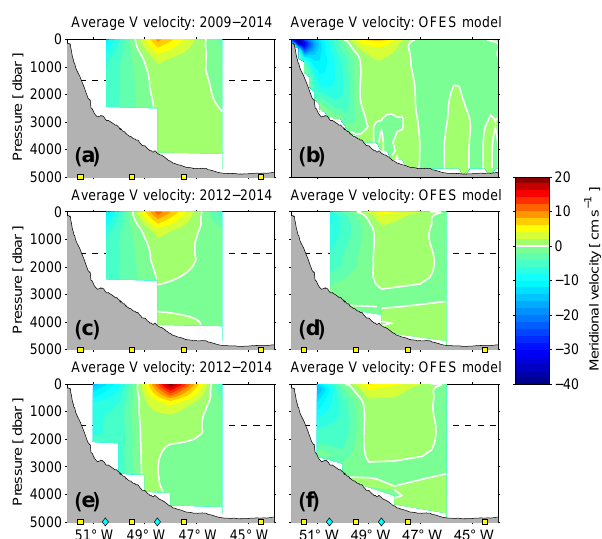
Figure 2. Time-mean meridional velocity from the PIES data (left panels) and from the OFES model (right panels). For the data-based mean sections: top panel indicates the mean over the full 5-year pe- riod for which data are available at the four PIES sites (denoted as yellow boxes on bottom axis); middle panel indicates the mean over only the ∼ 2 years when the array was augmented, but still using only the four PIES sites; bottom panel indicates the mean over the augmented ∼ 2 years but now using the additional CPIES sites (de- noted as cyan diamonds on bottom axis). For the model-based mean sections: top panel indicates the mean at 0.2 ◦ horizontal grid reso- lution; middle panel indicates the time mean with the profiles hor- izontally averaged between the PIES sites; bottom panel indicates the time mean with the profiles horizontally averaged between all PIES and CPIES sites. For all panels, the gray-filled shape indicates the bottom topography from the Smith and Sandwell (1997) data set. Horizontal dashed line indicates the level where the time mean from the model is used to reference the bottom-pressure variability. White contours in all panels indicate zero flow; color contours are at 2cms − 1